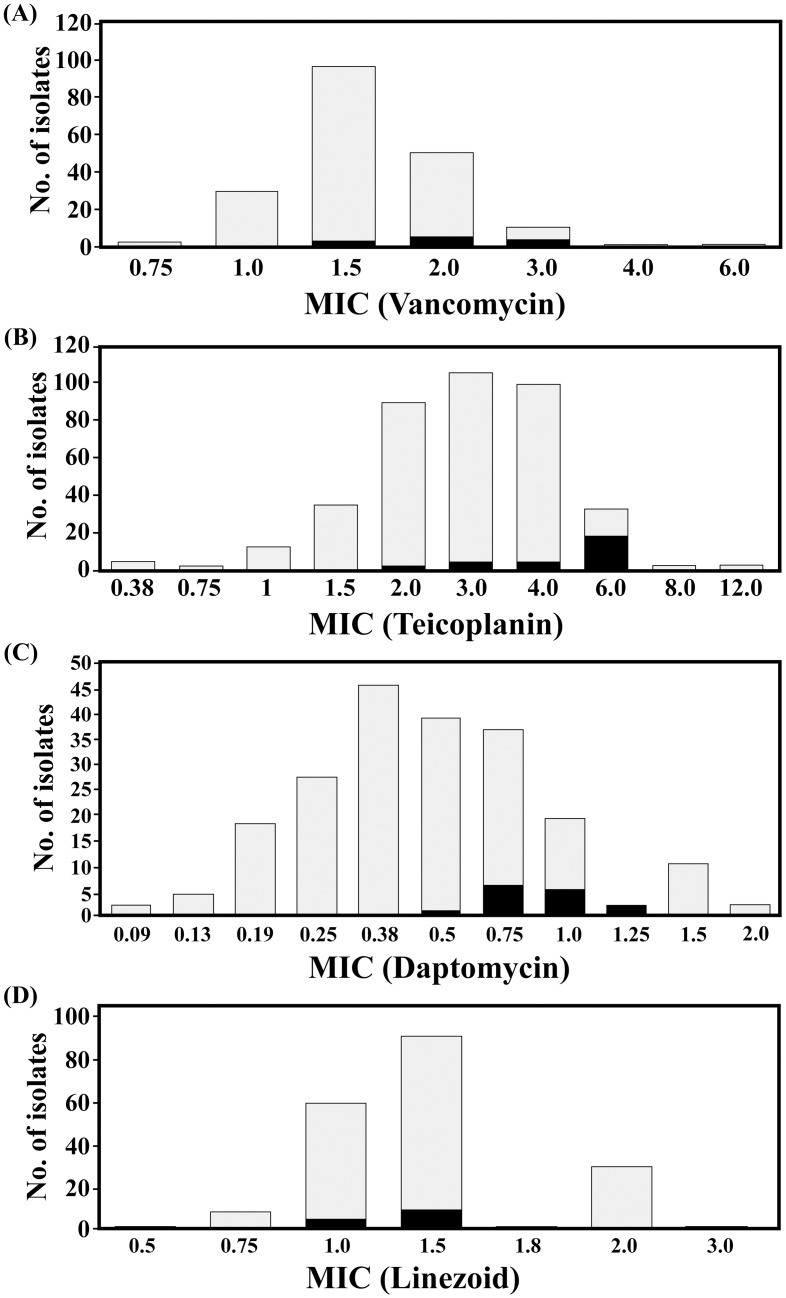
Distribution of methicillin-resistant Staphylococcus aureus (MRSA) bloodstream isolates with different minimum inhibitory concentrations (MICs) (mg/L) of various anti-MRSA agents (A, vancomycin; B, teicoplanin; C, daptomycin; D, linezolid).The isolate number of hVISA is shown in black.